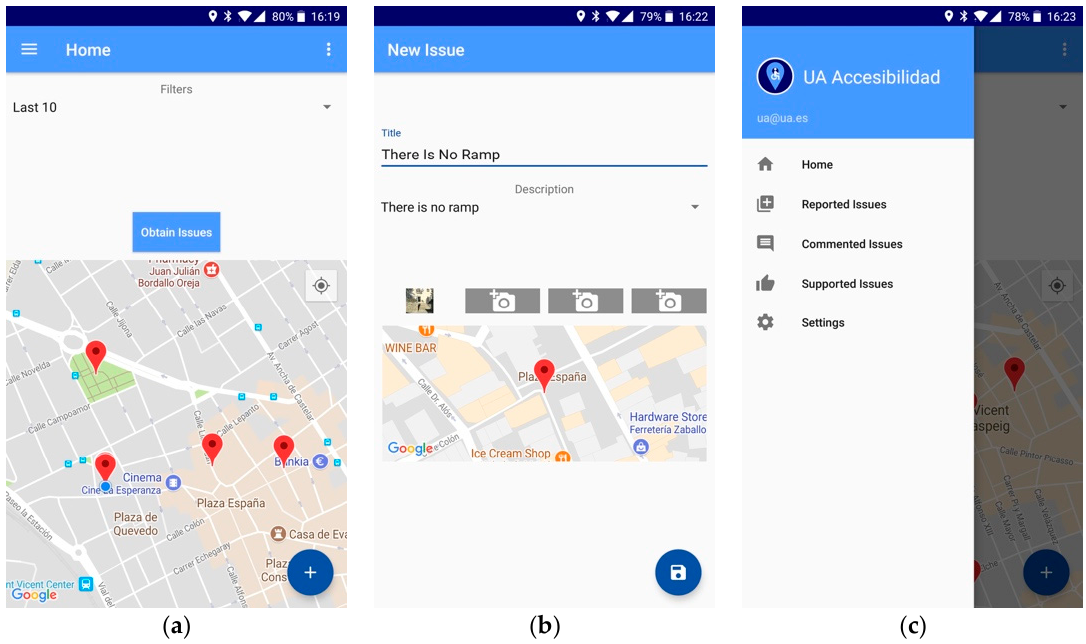
Figure 1. ( a , b ) Examples of the accessibility issues in the city of Alicante; ( c ) App